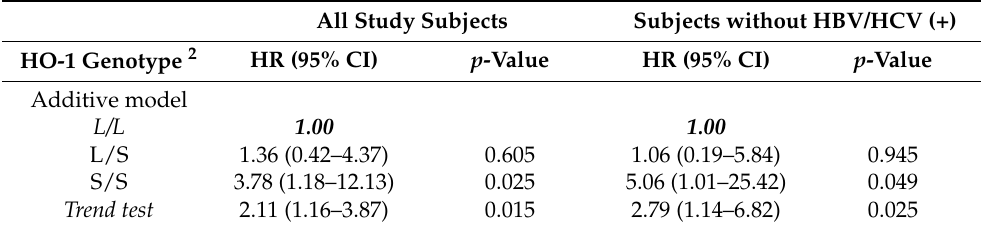
Table 3. Multivariate-adjusted hazard ratios (HR) 1 of the HO-1 promoter genotype in relation to liver cancer among study